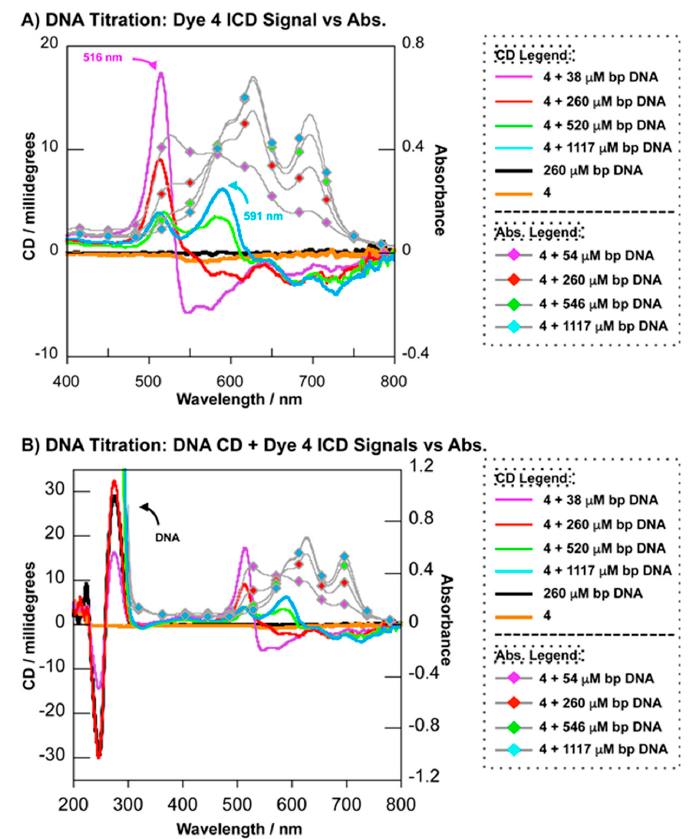
Figure 6. Double y -axis plots superimposing CD titration spectra (showing DNA CD and dye 4 induced circular dichroism (ICD) signals) vs. corresponding UV–visible absorption (Abs.) titration spectra (22 °C). Samples contained 10 mM sodium phosphate buffer pH 7.0 in the presence of 20 µM of dye 4 and/or CT DNA. Absorption spectra are from Figure 5A. ( A ): CD and absorption spectra are plotted from 400 to 800 nm. ( B ): The CD and absorption data in ( A ) re-plotted from 200 to 800 nm and 300 to 800 nm,